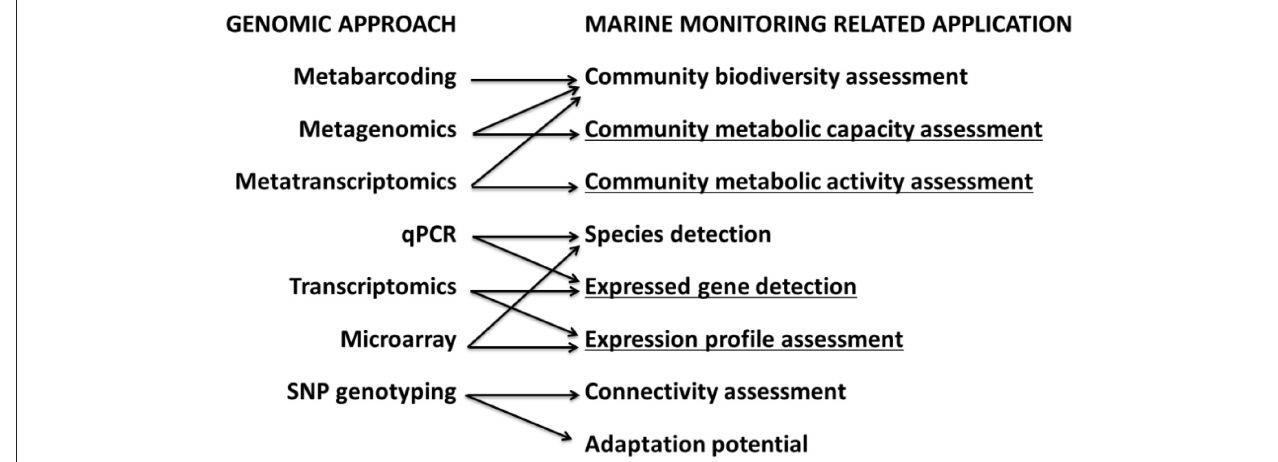
FIGURE 2 | Genomic approaches (left) and their potential marine potential application (right). Metabarcoding, metagenomics, and metatranscriptomics consist respectively on sequencing a region of the genome, the genome or the transcriptome of a whole community; qPCR (quantitative PCR) and microarrays consist on measuring the quantity of DNA or RNA in a given sample at low and high throughput respectively; SNP genotyping consists on determining the genotype of selected Single Nucleotide Polymorphisms of individuals from the same species in order to estimate differences in allele frequencies among populations. Applications that cannot be performed using traditional techniques are